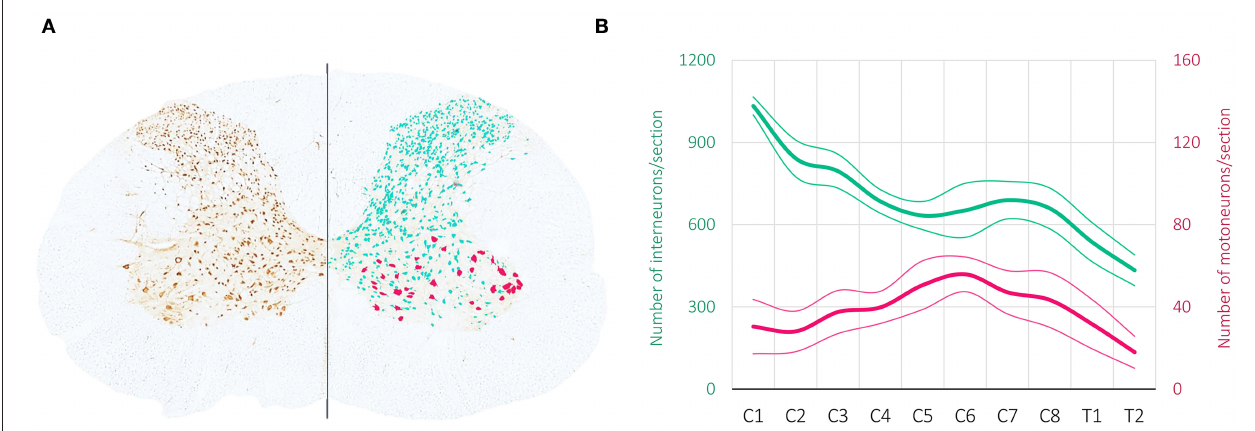
FIGURE 1 | Neurons in the cervical spinal cord. (A) Neural marker (NeuN) immunostaining of a transverse section from a rat C6 spinal segment. The left side shows the spinal section raw immunostaining, depicting the neuronal cell bodies distributed along the dorsal, mid, and ventral gray matter. The right side shows the image analysis performed to categorize and subdivide the identified neurons, based on their soma size and location, in interneurons (light green) and motoneurons (red). (B) The graph shows the mean ± SE of total interneurons and motoneurons quantified from individual serial sections of the cervical spinal cord from three uninjured adult rats. The number of motoneurons follows the anatomy of the cervical enlargement, with increasing numbers at C5–C7, where the motoneuron pools of the forelimb muscles are located (12). In contrast, the number of interneurons is higher at the most rostral cervical segments and gradually decreases along the rostro-caudal